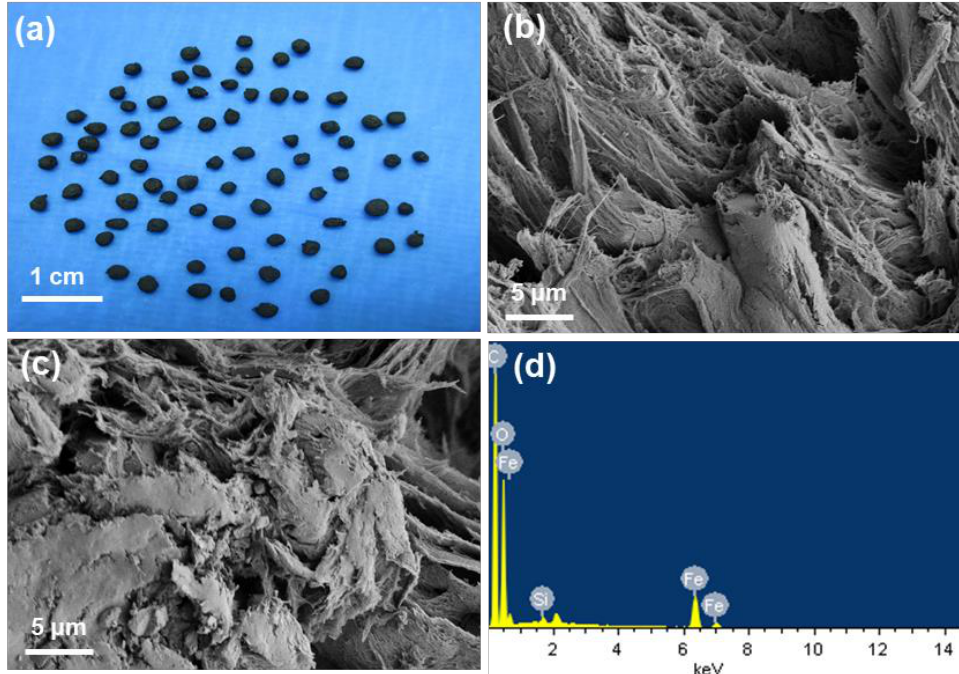
Figure 2. ( a ) Photograph of mPVA/AC CG beads. ( b ) SEM image of AC. ( c ) SEM image and ( d ) EDX spectrum of mPVA/AC CG sample.